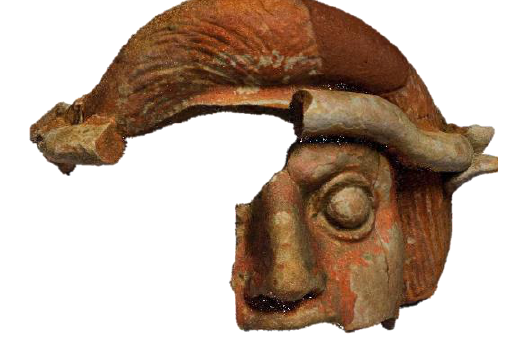
Figure 6. Point cloud